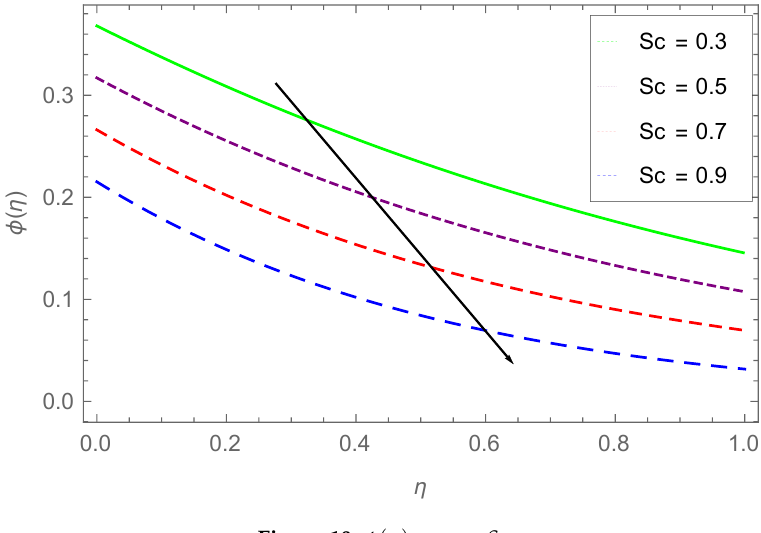
Figure 10. φ ( η ) versus Sc